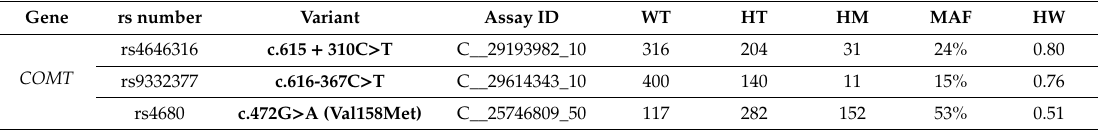
Table 2. Details and distributions of the studied single nucleotide polymorphisms